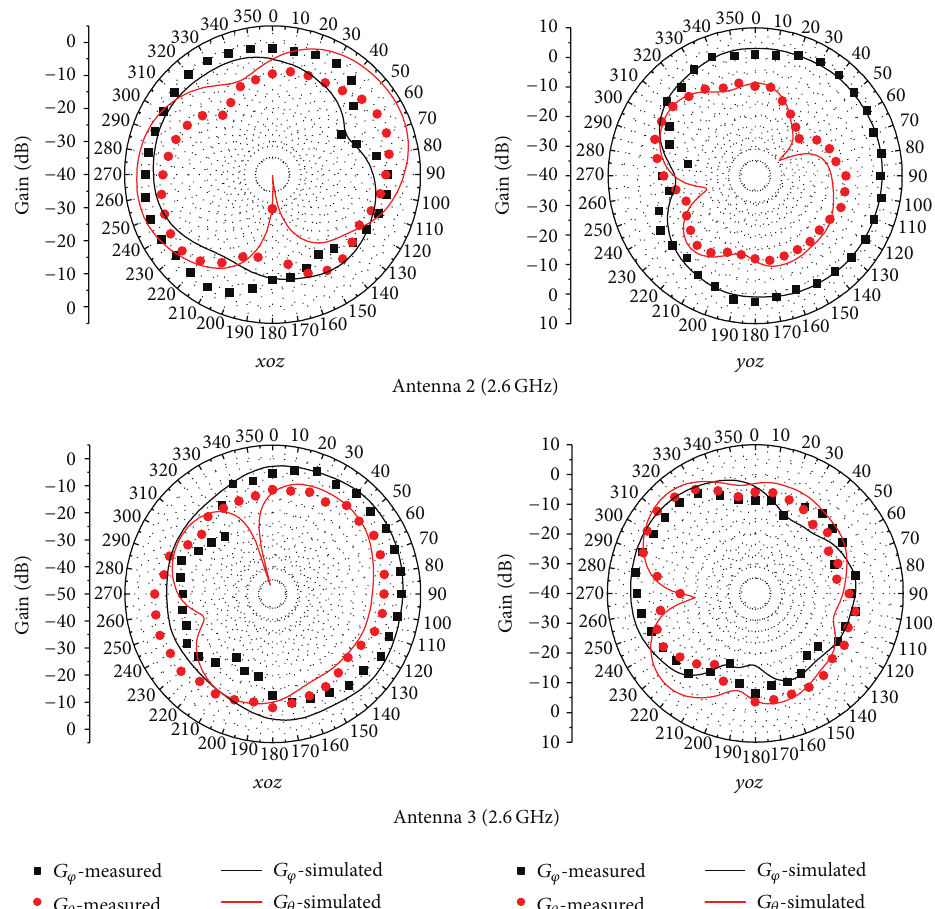
Figure 19: Measured and simulated radiation patterns of antennas 1, 2, and 3 at 1.9GHz and 2.6 GHz.